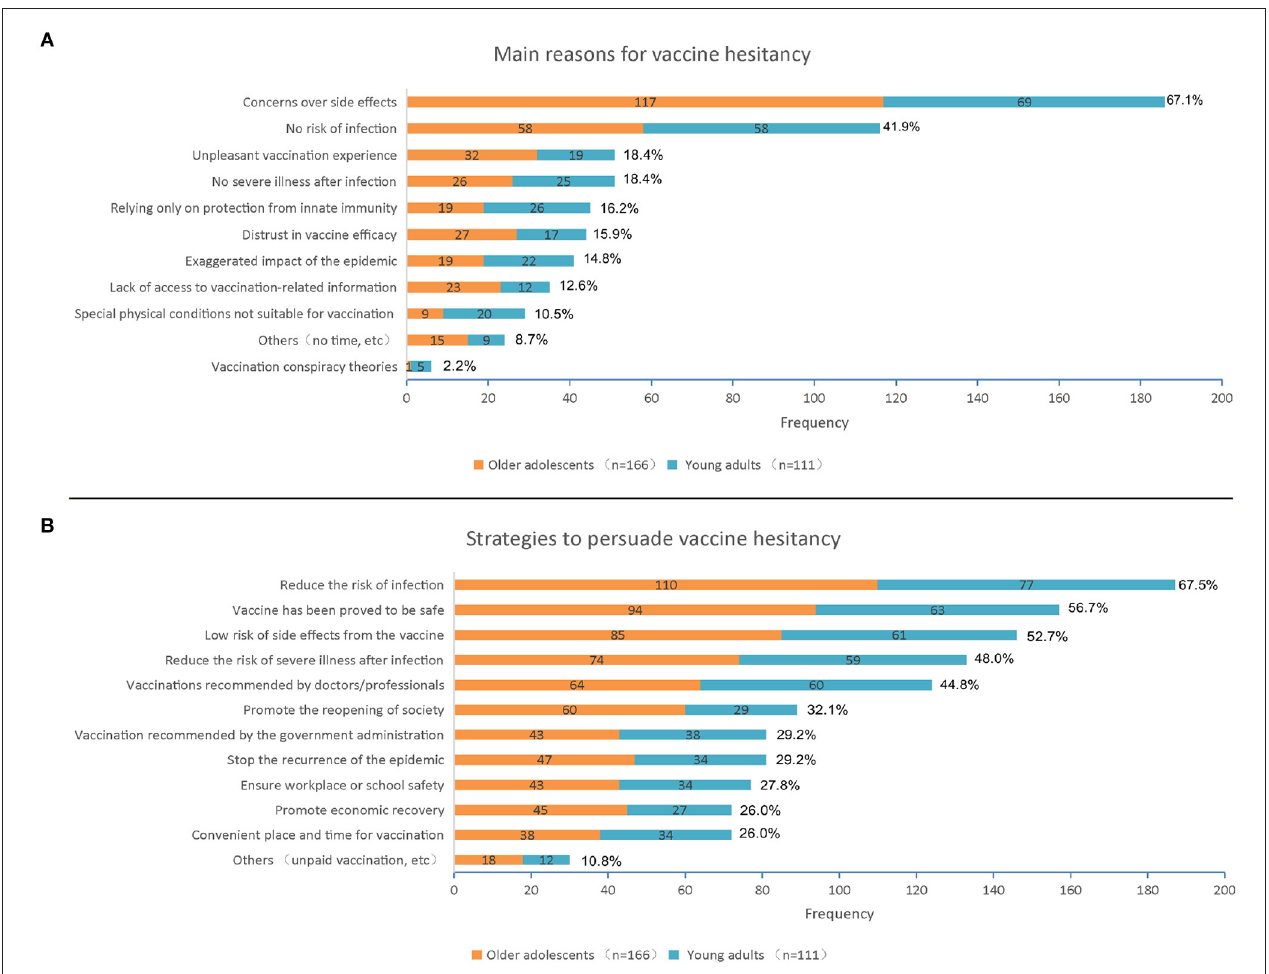
FIGURE 1 | (A) Main reasons for COVID-19 vaccine hesitancy within older adolescents ( N = 166) and young adults ( N = 111); (B) Strategies to persuade COVID-19 vaccine hesitancy within older adolescents ( N = 166) and young adults ( N = 111). COVID-19–the coronavirus disease 2019.